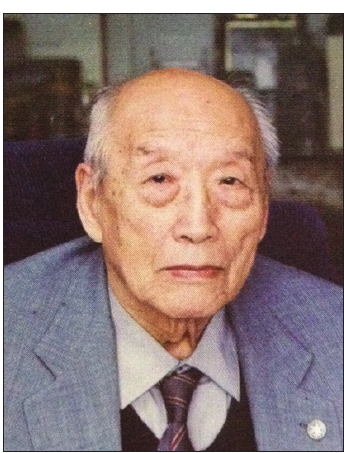
Figure 3: Professor Tsun Ko (Photo Thilo